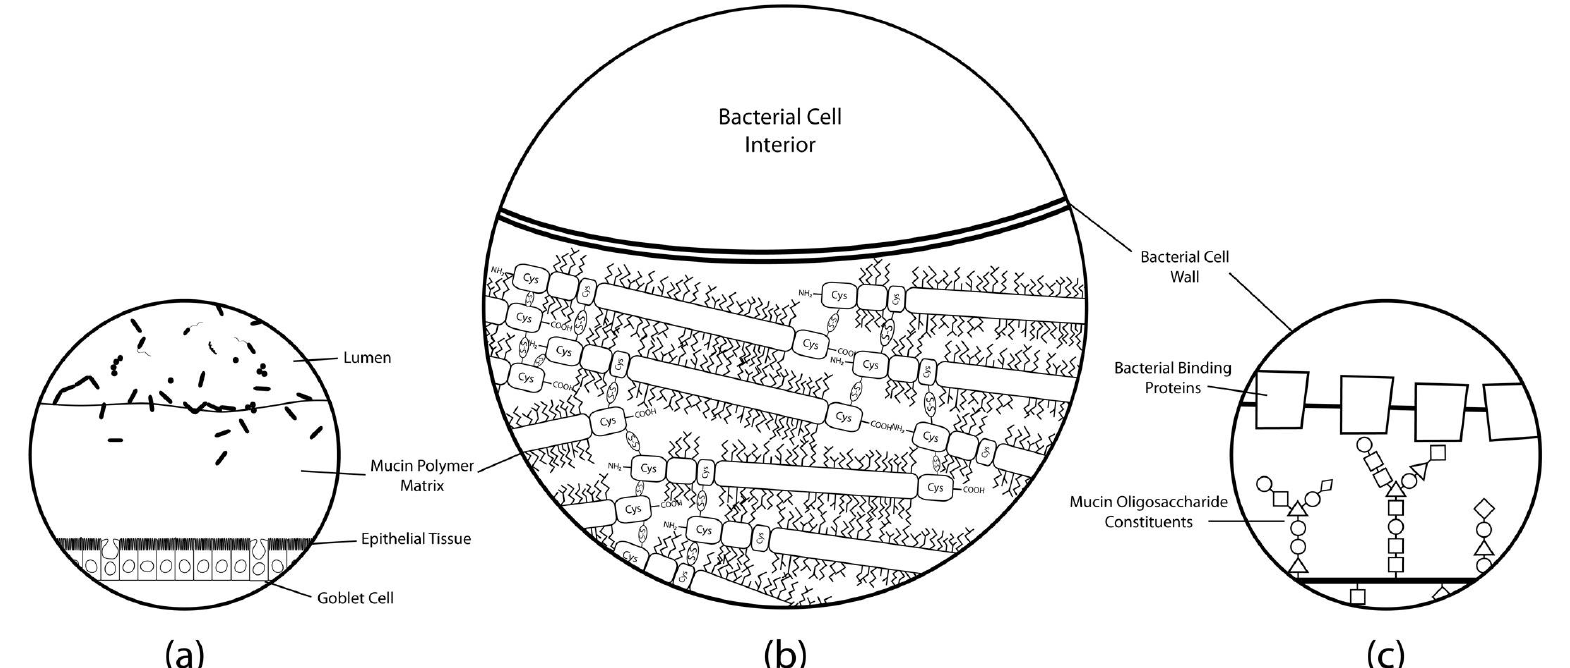
Figure 2. Simplified histological cross-section of microbial adhesion to the colonic mucosal surface at various magnifications. ( a ) The layer of mucus atop colonic epithelial villi. Goblet cells can be seen interspersed throughout the columnar enterocytes, producing secretory mucin that makes up the gel matrix. The microbial communities residing in and on top of the mucus layer can only be found at substantial concentrations in the outermost regions of the mucus; ( b ) The mucus-bacteria interface. The mucin molecules polymerize to form the mucus layer matrix to which cells adhere. Extensive disulfide bonding between cysteine-rich regions of the mucin protein cores creates the characteristic viscoelastic properties of mucus. Oligosaccharide modifications of mucin protein cores form ―bottle-brush‖ regions providing substrate for adhesion to binding proteins on bacterial cell surfaces; ( c ) A proposed molecular mechanism of adhesion. Evidence suggests that putative mucin-binding proteins anchored to the bacterial cell wall may interact with the glycosyl modifications of the mucin proteins to promote adhesion of the cell to the mucus layer. Mucin oligosaccharide structures vary due to tissue and cell-specific glycosyltransferase expression levels, so the specificity of particular oligosaccharide moieties may lead to preferential binding of particular bacteria to different host